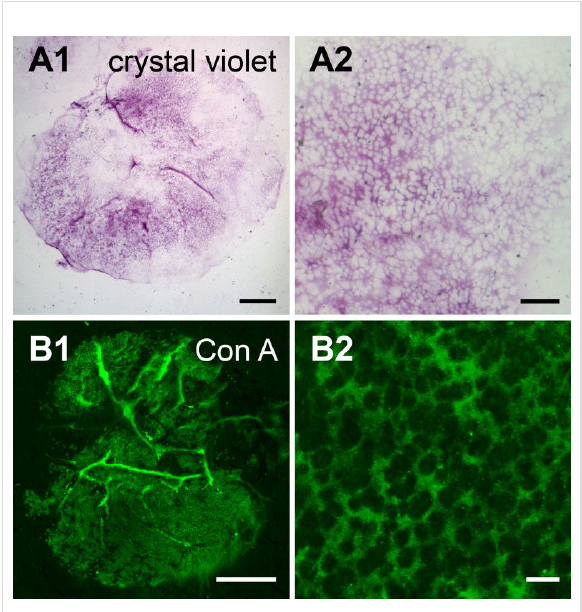
Figure 7: Structure of the footprints of Asterina gibbosa (light micros- copy). (A1,A2) Cristal violet staining of a fresh footprint. (B1,B2) ConA labelling of a PFA fixed footprint, confocal z -projections. (B2) Confocal z -projection exclusively at the level of the meshwork, above the thin layer. Scale bars: (A1,B1) 100 µm; (A2) 20 µm; (B2) 5